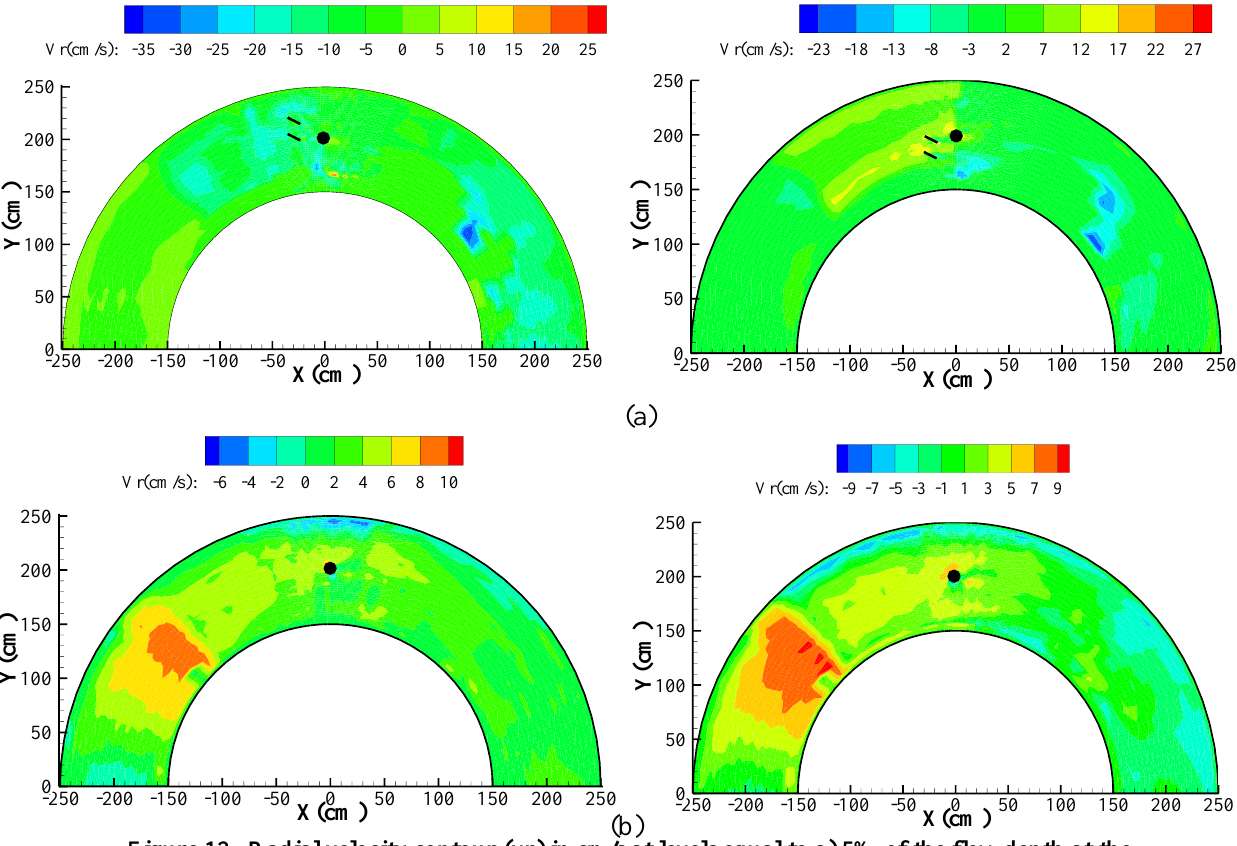
Figure 12. Radial velocity contour (vr) in cm/s at levels equal to a) 5% of the flow depth at the beginning of the bend from the bed, and b) 5% of the flow depth at the beginning of the bend from the surface (PFV experiment on the right, and PSV experiment on the